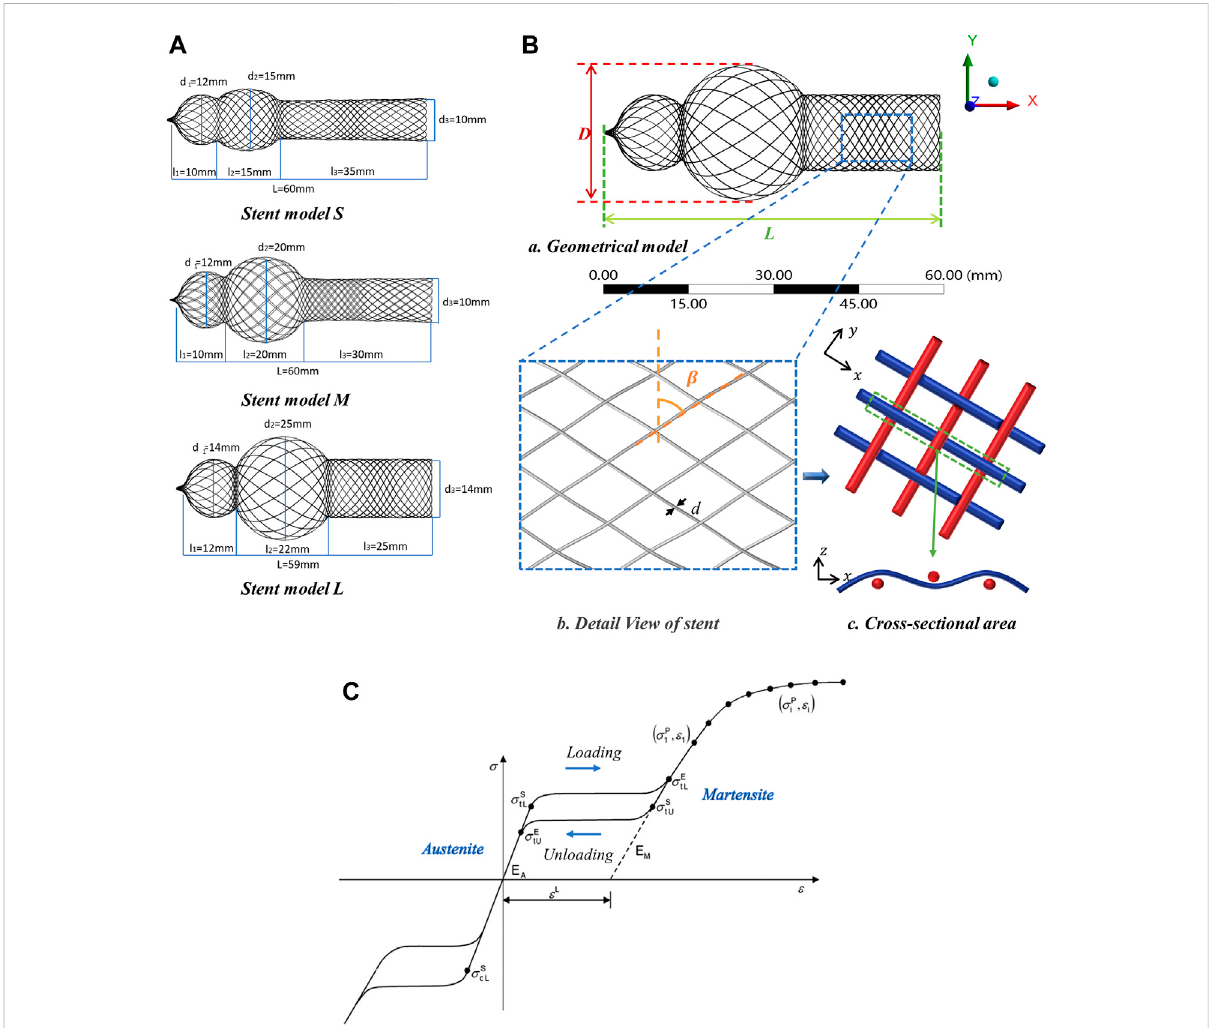
FIGURE 2 Design parameters of nasal stent model. (A) Three types of nasal stent model, S, M and L. (B) Braided geometrical parameters of nasal stent. (a) Geometricalmodel:externalstentdiameter( D ),stentlength( L ).(b)DetailViewofstent:braidingangle( β ),wirediameter( d ).(c)Cross-sectionalarea: interlaced con fi guration of the braiding wires inside the stents. (C) Material property: σ tL S , σ tL E loading phase transformation starts/ends stress; σ tU E ,